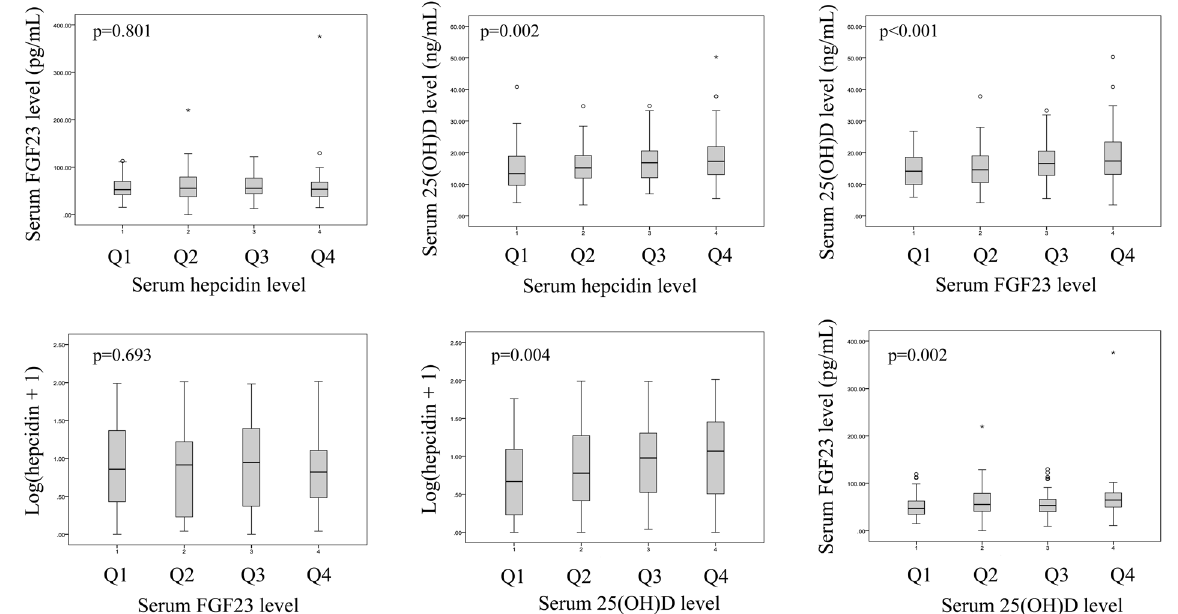
Figure 3. Relationships among serum hepcidin, FGF23, and 25(OH)D levels. Each factor was divided into four groups (Q1–Q4), and distributions of other factors are indicated in relation to each quartile.